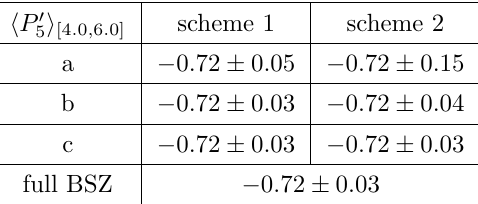
Table 2 . SM prediction for P 0 in the anomalous bin [4 ; 6] GeV 2 together with the error from soft 5 form factors and factorisable power corrections (all other sources of errors have been switched o(cid:11)). Results are shown for the three di(cid:11)erent options for the treatment of power corrections and for the two di(cid:11)erent input schemes discussed in the text. The last row contains the prediction from a direct use of the full form factors from ref.